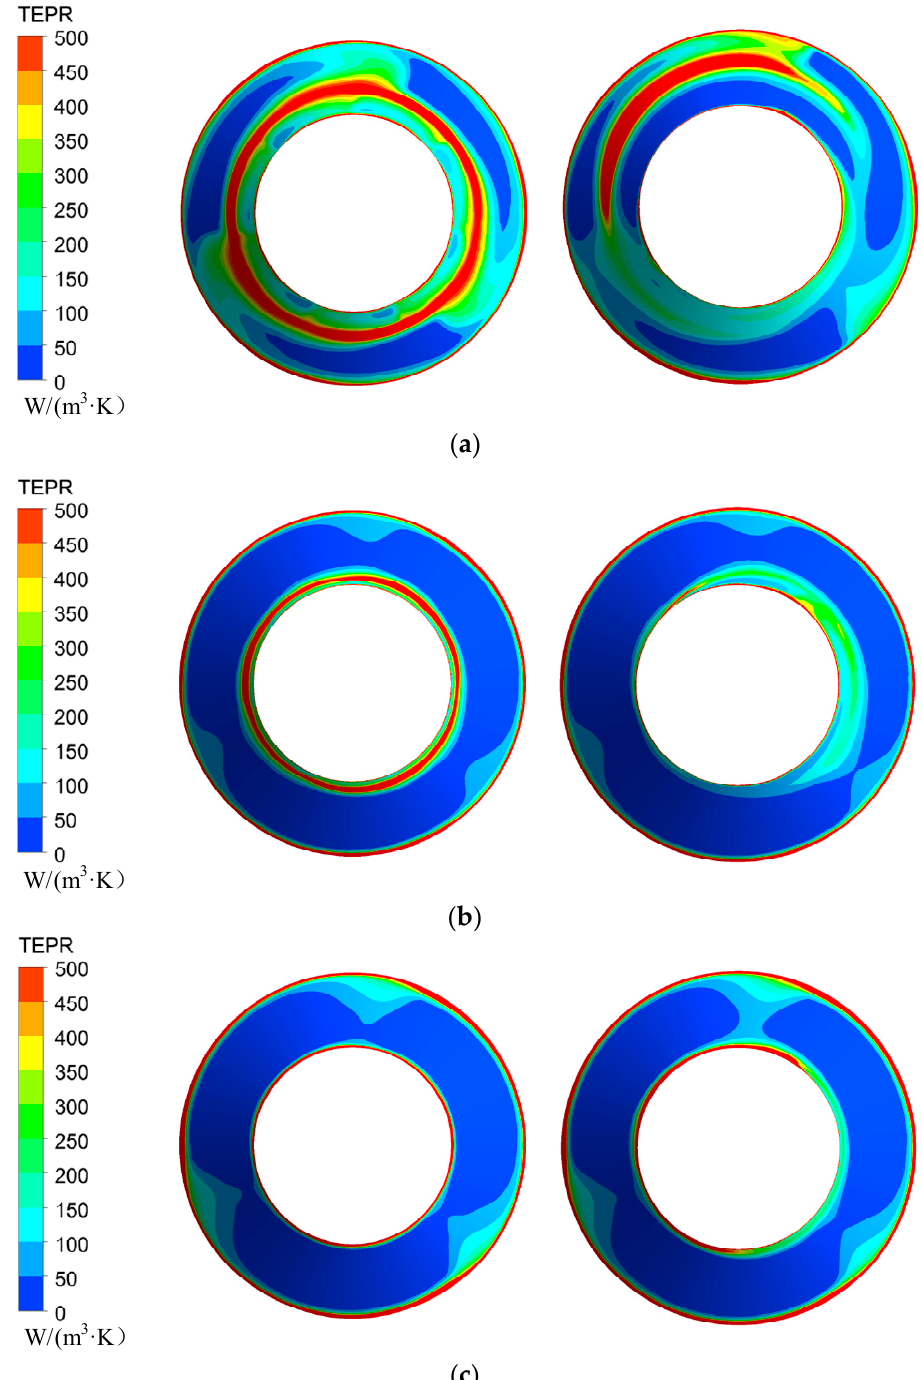
Figure 10. The average radial distribution of Γ at impeller outlet under ( a ) Q = 800 m 3 /h, ( b ) Q = 1200 m 3 /h, and ( c ) Q = 1600 m 3 /h.